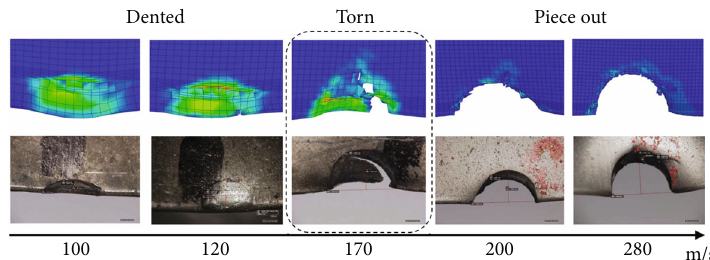
Figure 15: Comparison of experimental results with simulation results for 60 ° impact.